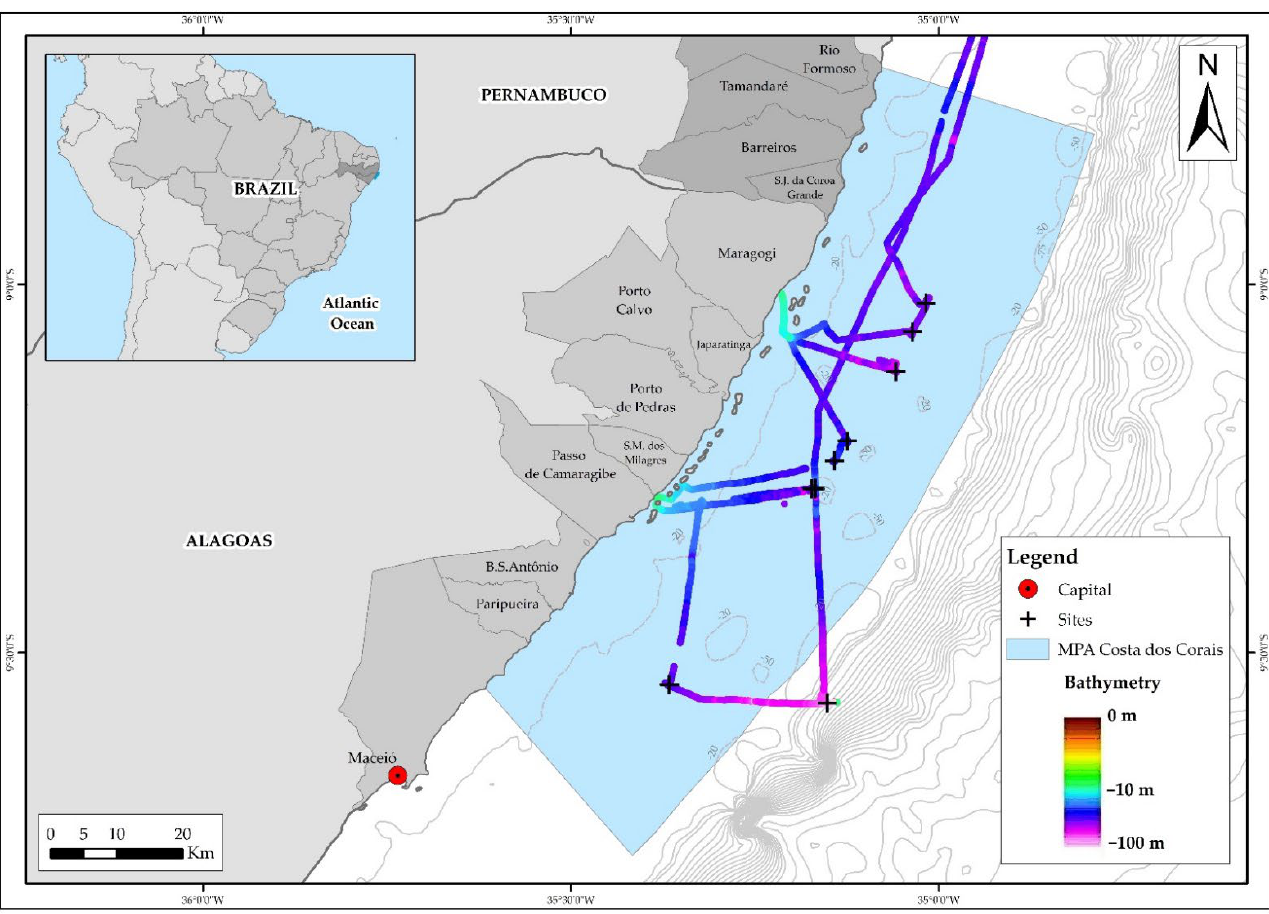
Figure 1. Map of the study area highlighting MPA Costa dos Corais and the route during the Yacaré 2021 expedition—March 2021. Bathymetric detailing of the selected areas is demonstrated from more than 90,000 depth points acquired at MPA Costa dos Corais.